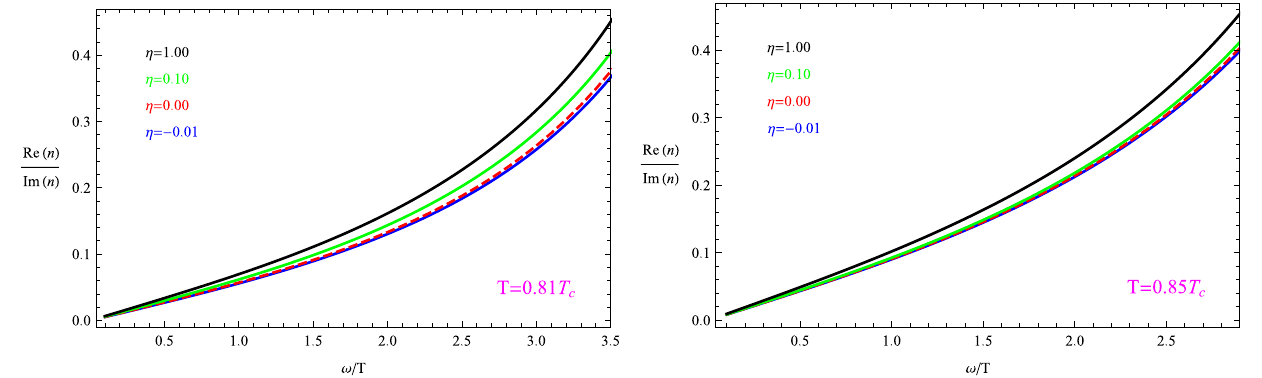
Fig. 12 Ratio Re ( n )/ Im ( n ) as a function of ω/ T with the fixed tem- peratures T = 0 . 81 T c (left) and T = 0 . 85 T c (right) for different values of the coupling parameter, i.e., η = − 0 . 01 (blue), 0 . 00 (red dotted),